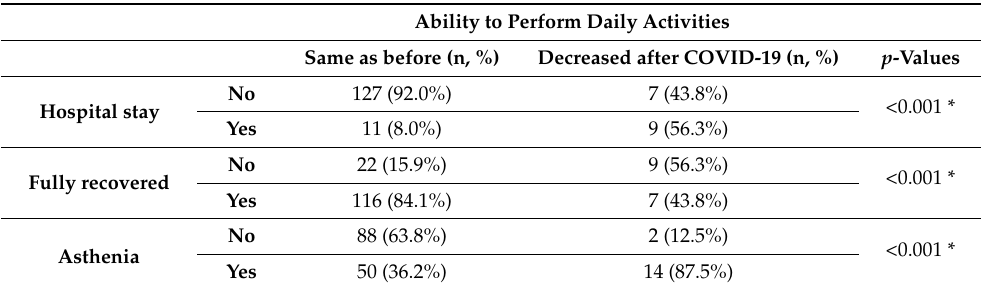
Table 4. Significant chi-square tests correlating ability to perform daily activities with hospital stay, feeling fully recovered and asthenia (* p ≤ 0.05).